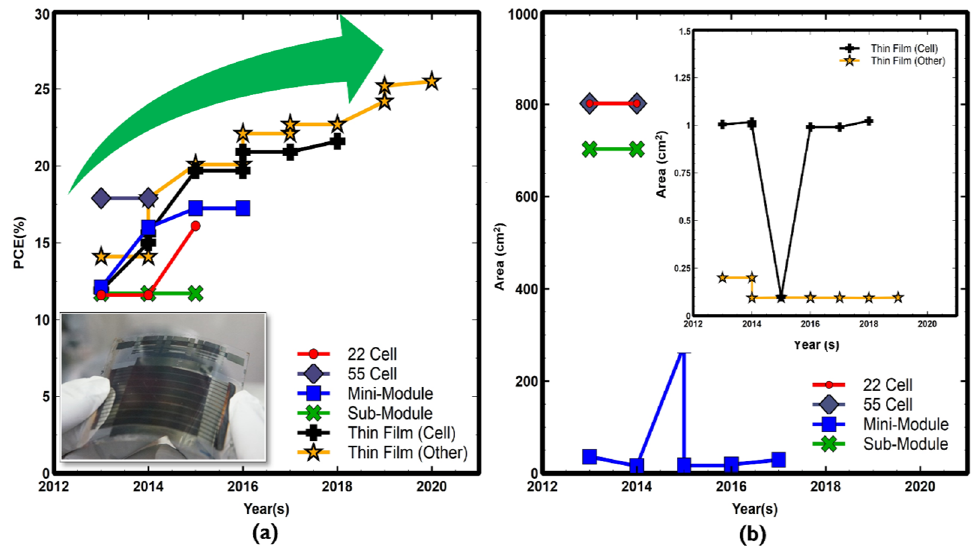
Figure 3. Illustration of the certified various perovskite cell and multi-cells, ( a ) the efficiency trend, the inset shows real minimodules produced by Toshiba [81]; ( b ) the area of the corresponding cells for the same period for higher cells area, and the inset represents the corresponding thin film (various) small area graph. Some data points in Figure 3 coincide with each other. Data are obtained from solar cell efficiency tables (42–57) available at www.onlinelibrary.wiley.com.